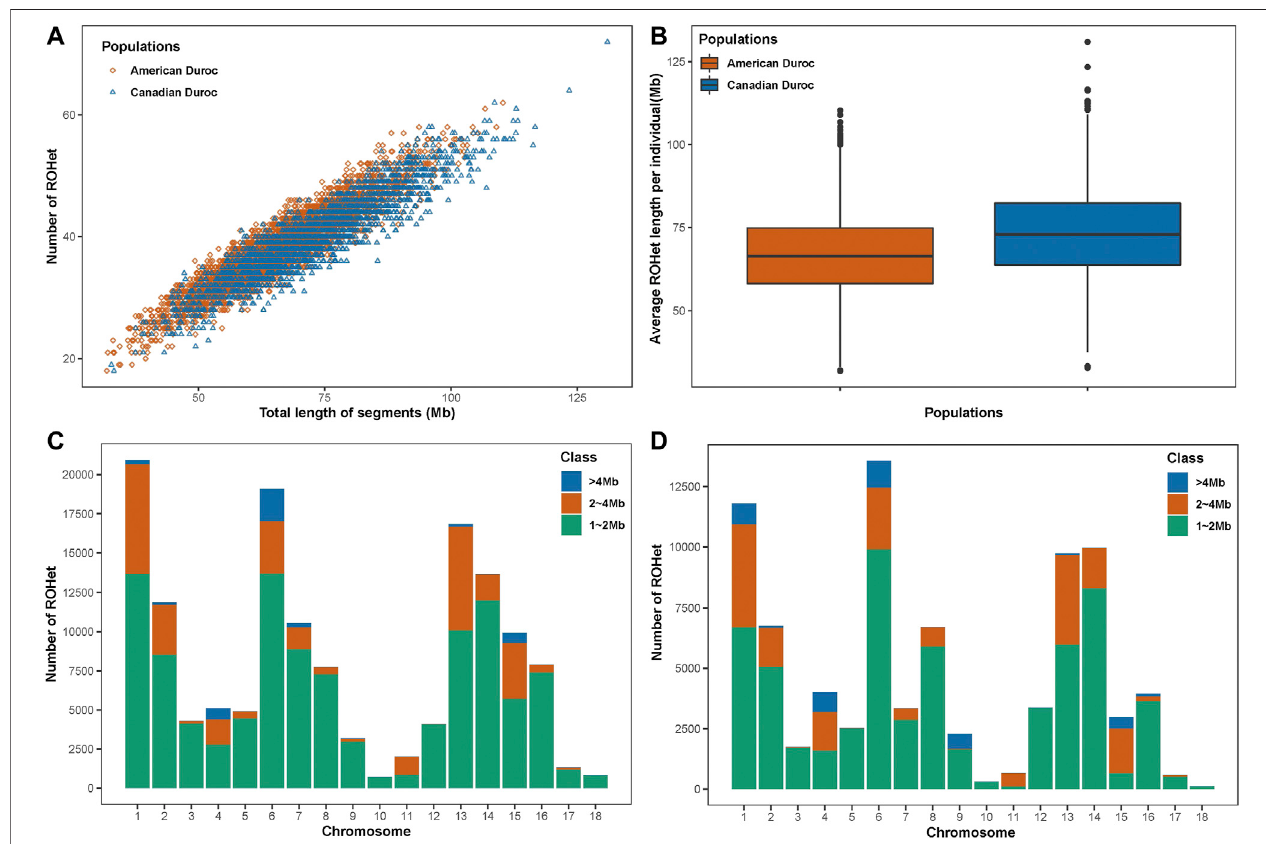
FIGURE 1 | ROHet statistics in two Duroc populations. (A) Number and total length of ROHet per individual for two Duroc populations. (B) Average ROHet length per individual for twoDurocpopulations. (C) Number oftotal ROHet and number ofROHet classes per chromosomefor theS21 population. (D) Number oftotal ROHet and number of ROHet classes per chromosome for the S22 population.